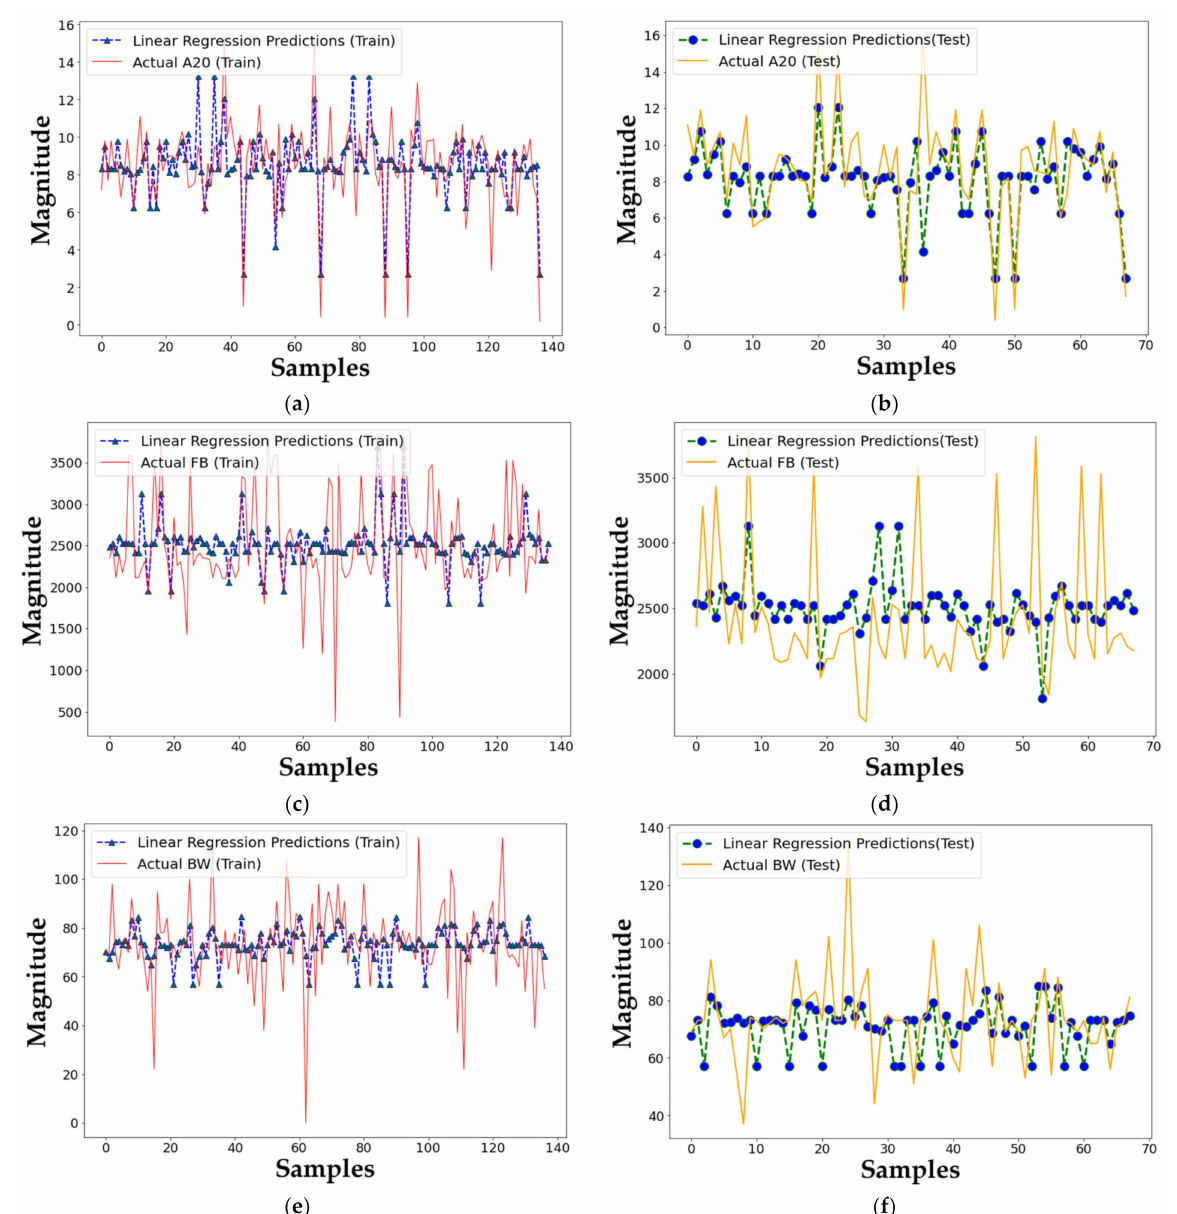
Figure 6. Description of the performance of ML Linear Regression in modelling the digital twins of the alloy based on A20 ( a , b ); FB ( c , d ); BW ( e , f ) in the presence of all inputs including, Heating, QT, PT, and Pt; ( a , c , e ): Train and ( b , d , f ):